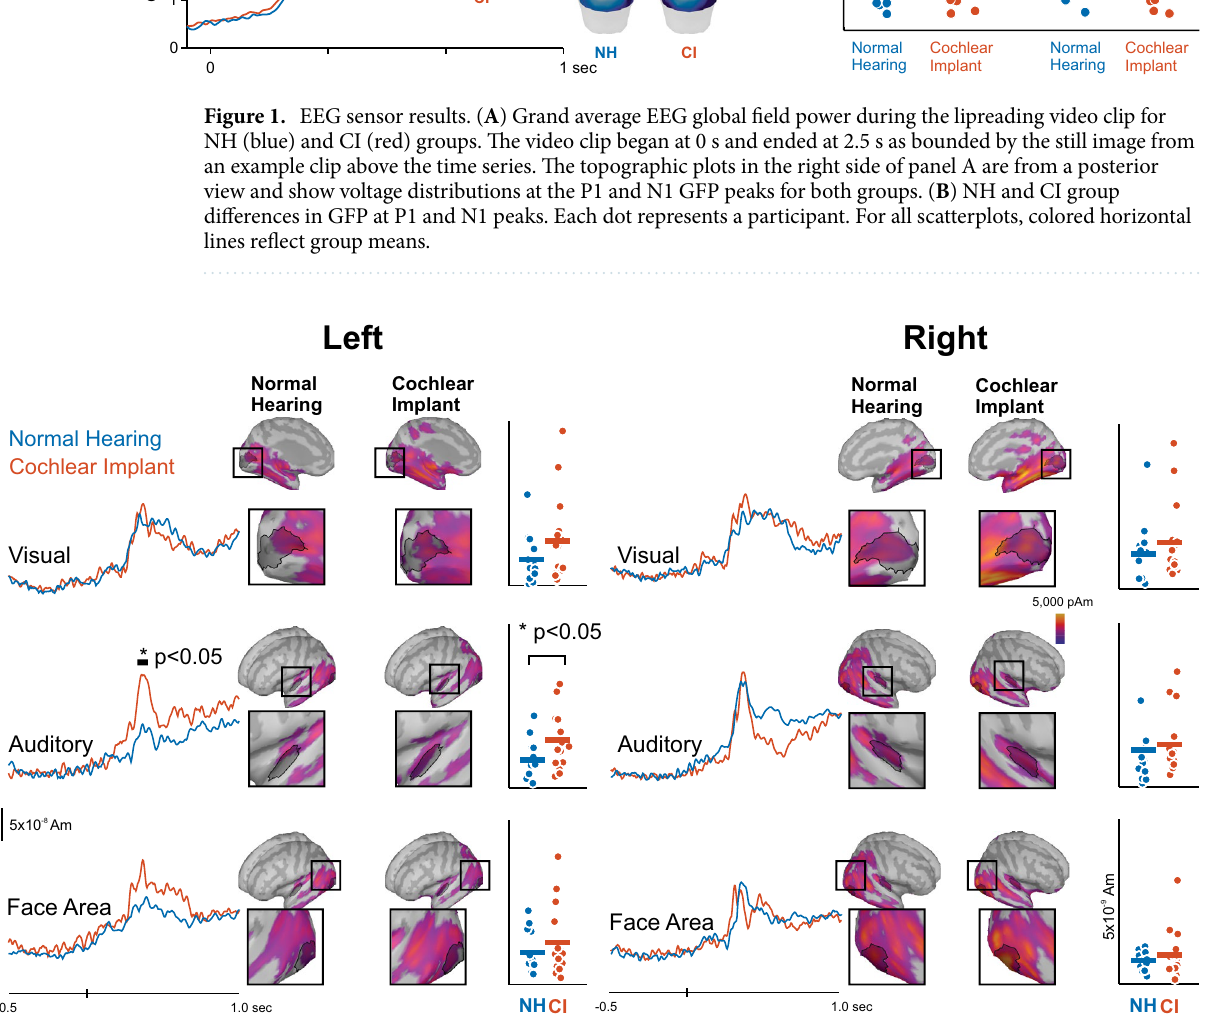
Figure 2. For left and right visual, auditory, and face ROIs illustrated as outlined regions on brain templates, sLORETA activations fit to the peak N1 GFP response following the video onset are shown as a time series comparing CI users (red) and NH controls (blue). ROI boundaries for each region on left and right sides are shown within brain plots shaded with higher activation toward yellow and lower activation toward purple. For each region, individual differences for each group are shown as scatterplots in the rightmost panels. For all scatterplots, colored horizontal lines reflect group